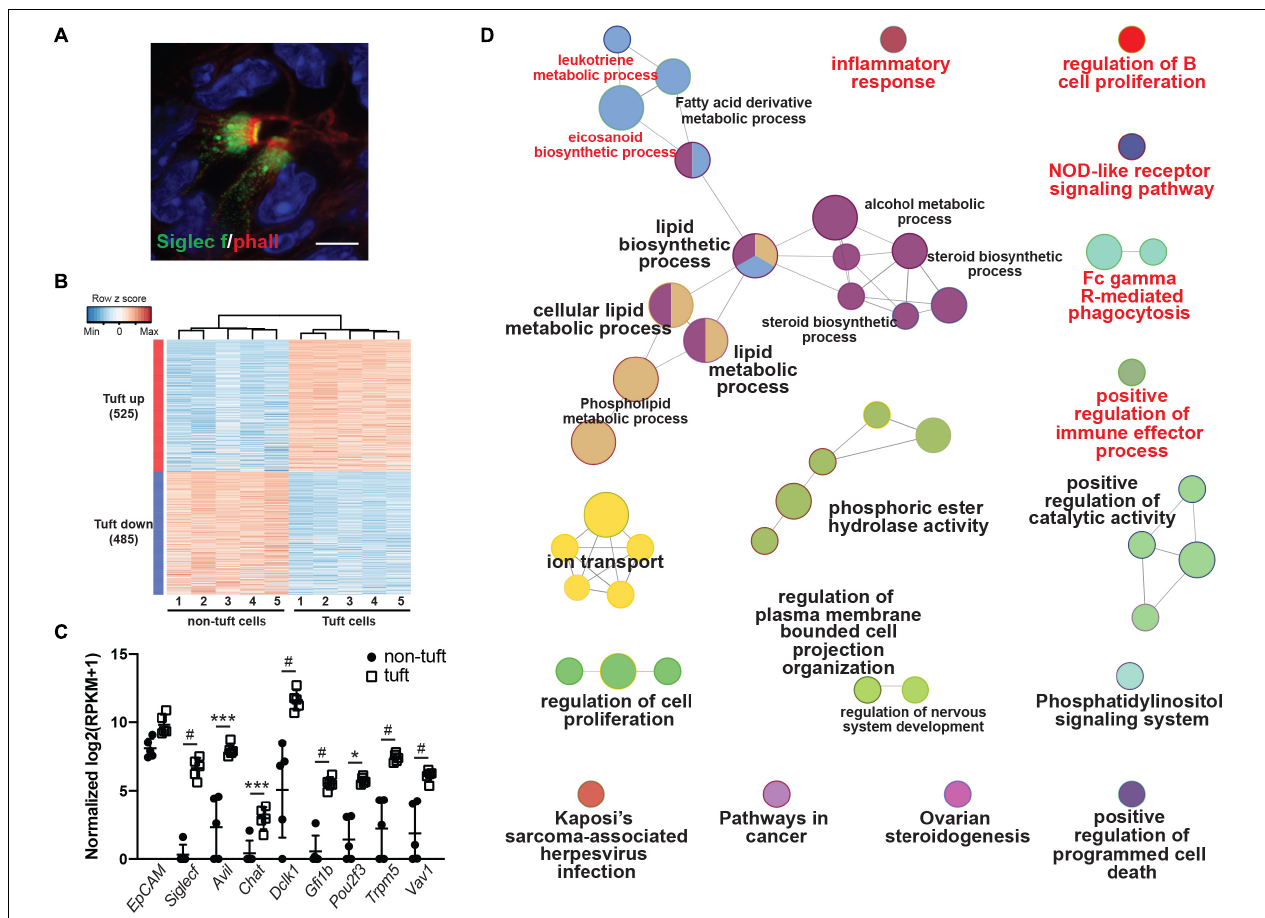
FIGURE 2 | Transcriptomic analysis of pancreatitis-induced tuft cells in wild type CD1 mice. (A) Co-immunofluorescence for phalloidin (red, labels the microvilli and actin rootlets of tuft cells) and Siglec f (green) in the injured pancreas. Scale bar, 5 µ m. (B) Heat map with hierarchical clustering showing differentially expressed genes in EpCAM+; Siglec f+ tuft cells as compared to EpCAM+; Siglec f-neg non-tuft epithelial cells. (C) Confirmation of Siglec f expression and tuft cell markers in sorted EpCAM+; Siglec f+ cells. n = 5 mice. (D) Gene ontology network analysis of genes differentially up-regulated in tuft cells, as compared to non-tuft epithelial cells, identifies immune cell signaling pathways (labeled in red). * p < 0.05; *** p < 0.005; # p < 0.001.